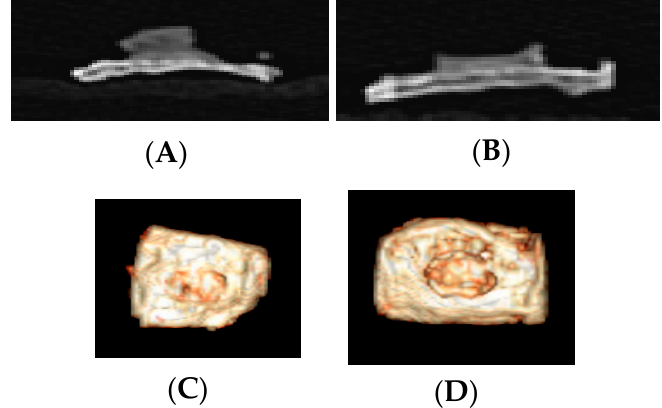
Figure 5. Tomographic images of Groups 3 ( A , C ) and 4 ( B , D ), where bone tissue beyond the skullcap can be observed.